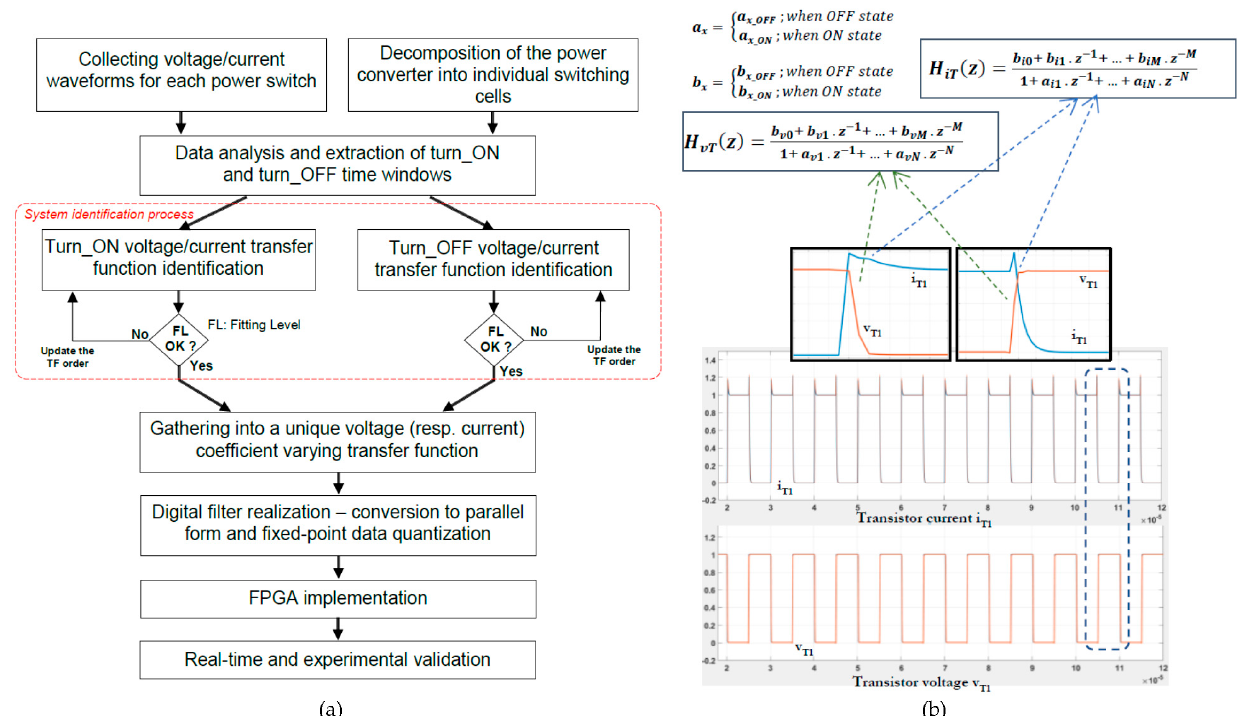
Figure 2. Overview of the proposed modeling approach—main development steps. ( a ) Modeling process, ( b ) approximation to unified transfer functions. Reprinted/adapted with copyright permission from [26].